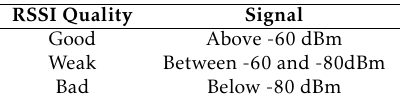
Fig. 2 . (b) Network transmission behavior impact on suspend/ resume mode switch